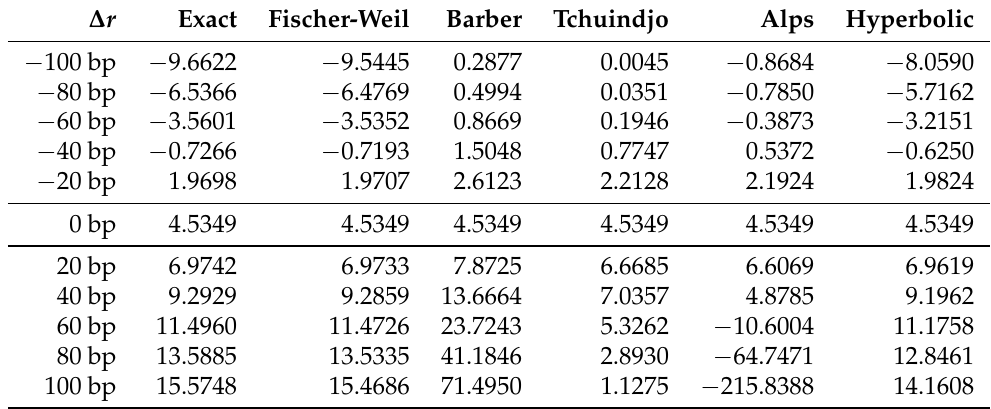
Table 2. NPV of 10-year annuity with annual payments of 10 and a payment of − 120 at time 20. ∆ r Exact